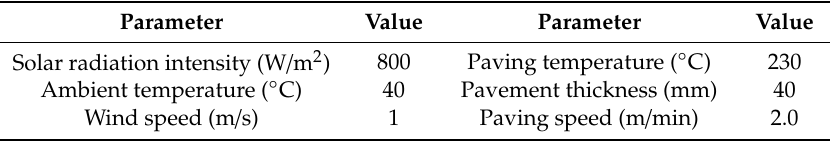
Table 1. Environmental and paving parameters for thermal analysis.